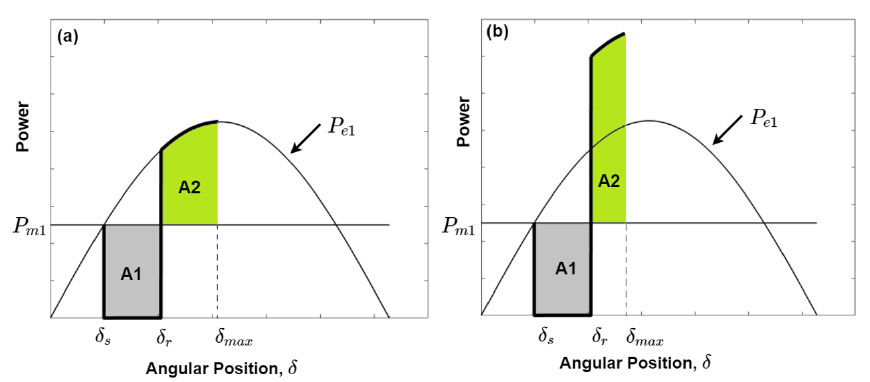
Figure 9. ( a ) EAC of the two machine equivalent system. ( b ) EAC of the controlled two-machine system. At pre-fault state, ω s = 0; hence, the accelerating area A1 is equal to the kinetic